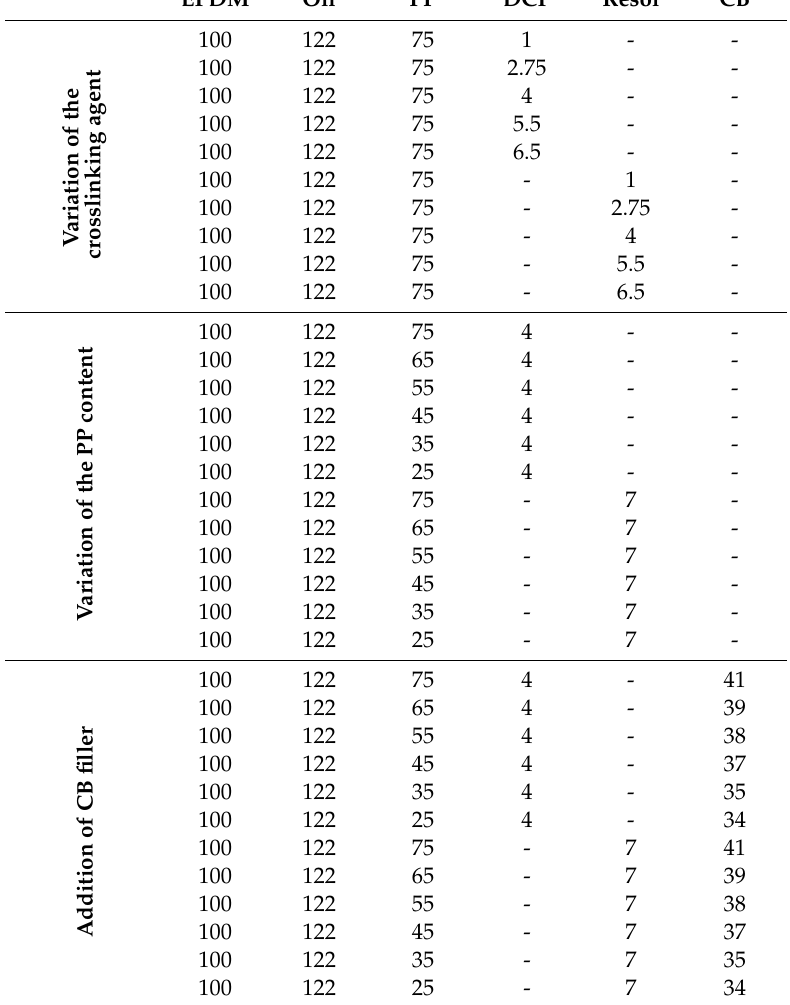
Table 1. Formulations of samples prepared in the batch mixer according to the mixing process described in Figure 3 (in